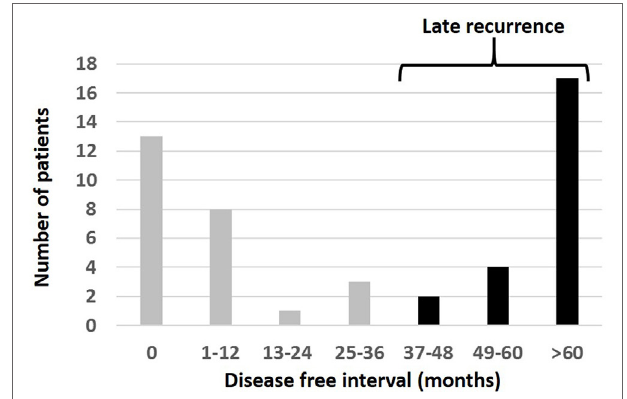
FigUre 2 | Interval from the time of diagnosis of primary melanoma to the appearance of orbital disease in 48 patients presenting with melanoma in the orbit. Patients were considered to have “late recurrence” when orbital disease presented more than 3 years after the primary diagnosis elsewhere.